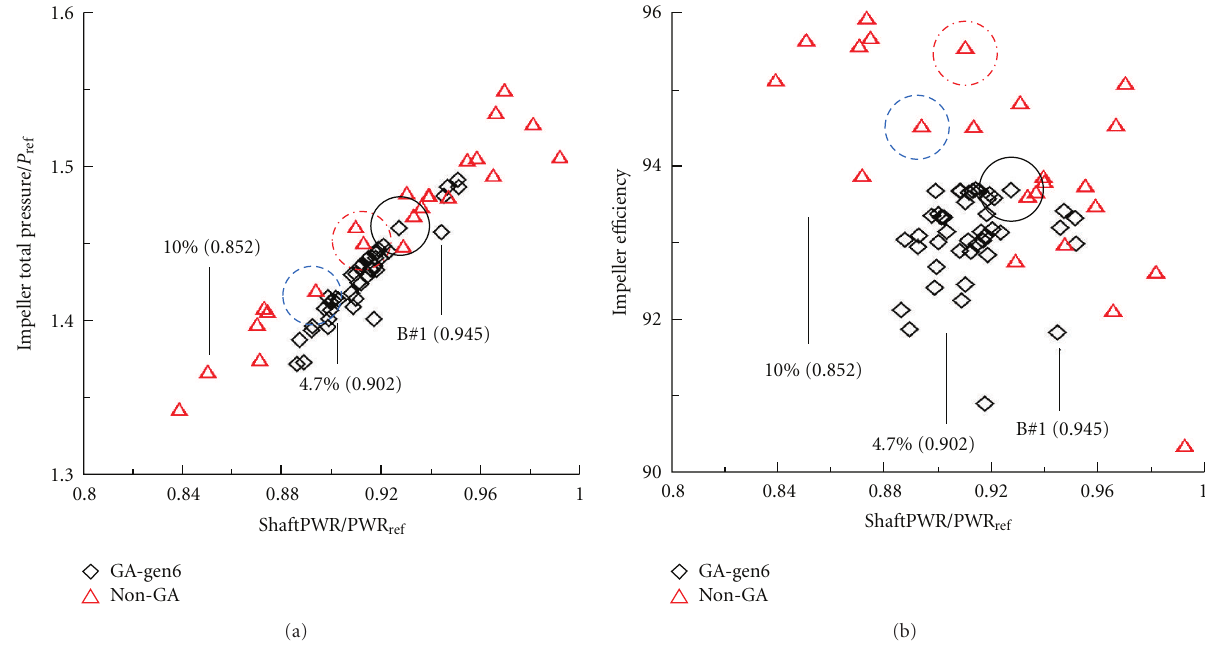
Figure 12: Landscape of optimization process in total pressure and e ffi ciency versus ShaftPWR (black solid circle indicates result obtained from 2D design, blue dash circle is from 2D steering, and red dash-dot circle is from 3D design).